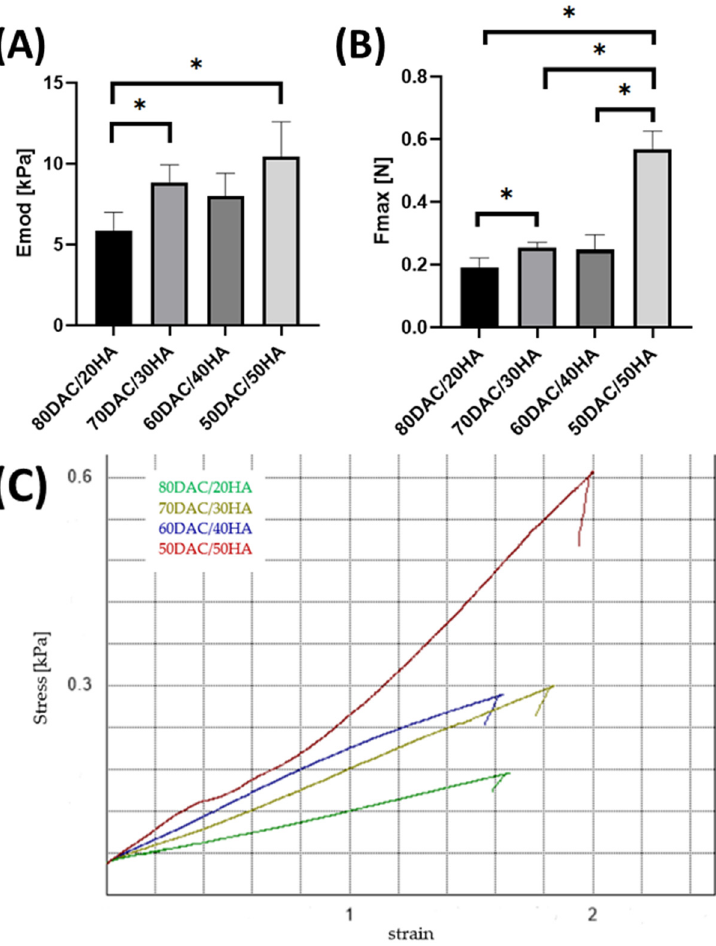
Figure 3. Mechanical parameters of dialdehyde chitosan/hyaluronic acid (DAC/HA) scaffolds: ( A ) compressive modulus (E mod ), ( B ) maximum compressive force (F max ), ( C ) stress strain curves (* significantly different, p < 0.05).